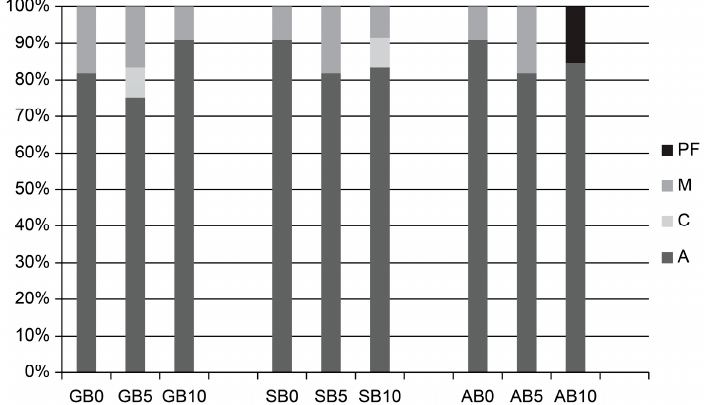
Figure 3. Distribution of the failure modes (%) in etch-and rinse mode. GB0 : 0 s group for G-Premio Bond; GB5 : 5 s group for G-Premio Bond; GB10 : 10 s group for G-Premio Bond; SB0 : 0 s group for Single Bond Universal; SB5 : 5 s group for Single Bond Universal; SB10 : 10 s group for Single Bond Universal; AB0 : 0 s group for All Bond Universal; AB5 : 5 s group for All Bond Universal; AB10 : 10 s group for All Bond Universal. PF : premature failure; M : mixed failure; C : cohesive failure; A : adhesive failure.